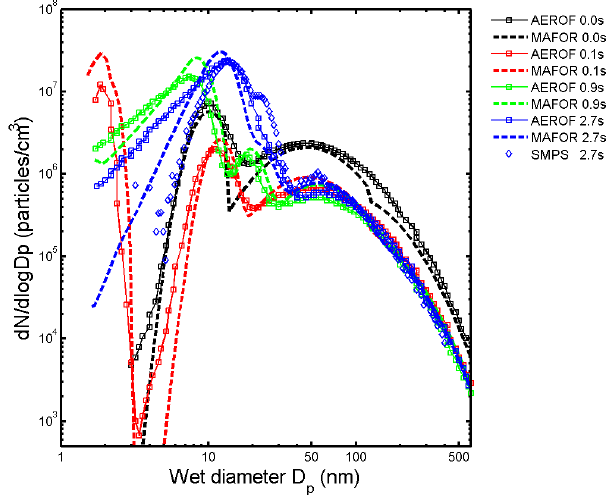
Figure 7. Number size distribution (d N/ dlog D p in particlescm − 3 ) at different stages of the exhaust ( t = 0.0s, black lines; t = 0.1s, red lines; t = 0.9s, green lines; t = 2.7s, blue lines) as modelled by AEROFOR (lines with open squares) and by MAFOR (dashed lines) together with the SMPS measurement at 2.7s (blue open di- amonds). Initial size distribution with the core mode at 10nm and soot mode at 49nm. The nucleation mechanism for these simula- tions was